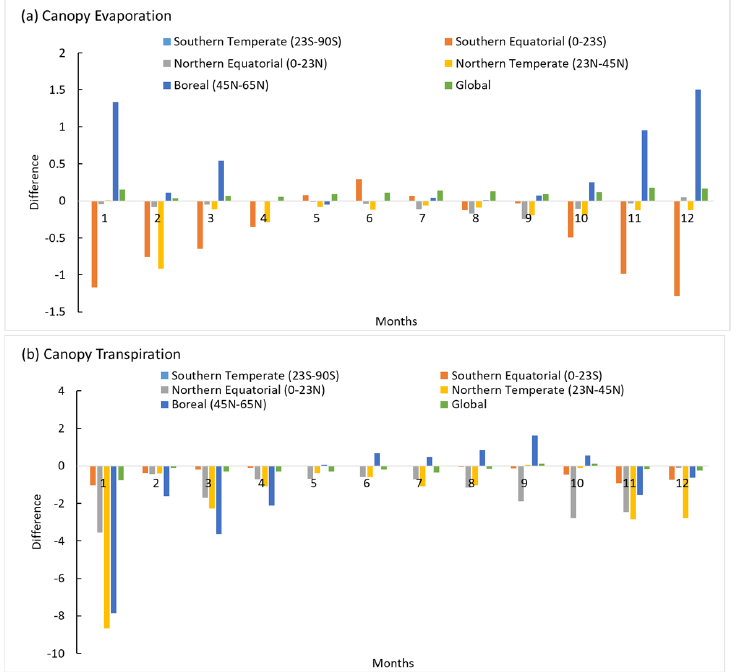
Figure 10. The zonal distribution of differences in ( a ) evaporation (W/m 2 ) and ( b ) transpiration (W/m 2 ) between ESACCI and CLM_LS.